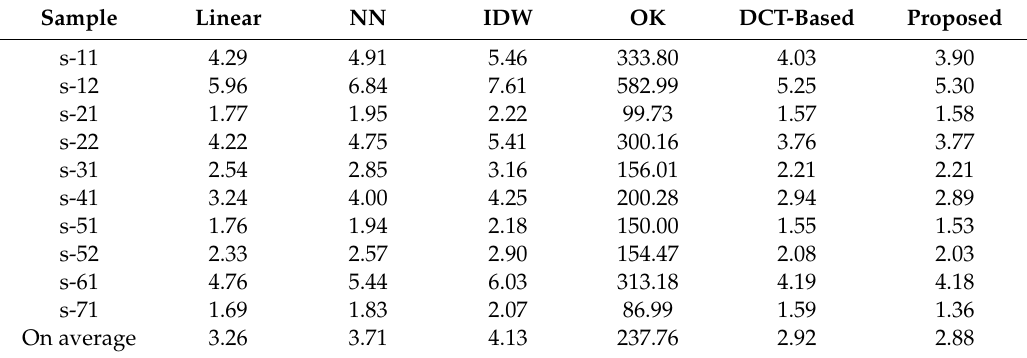
Table 5. Rasterization time (reading the points, interpolation, and writing on disk) of the proposed method and the other interpolation methods on the public datasets (unit: s).